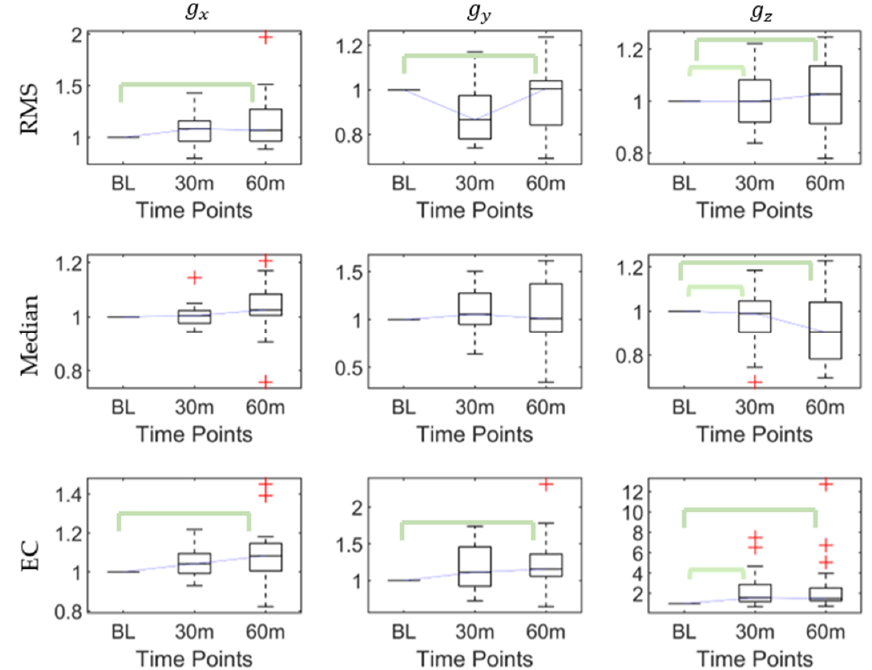
Figure 4. The root mean square (RMS), median, and energy consumption (EC) of angles at baseline, 30th min, and 60th min. Bracket denotes statistical significance ( p < 0.05) in the post hoc analysis with Bonferroni correction.